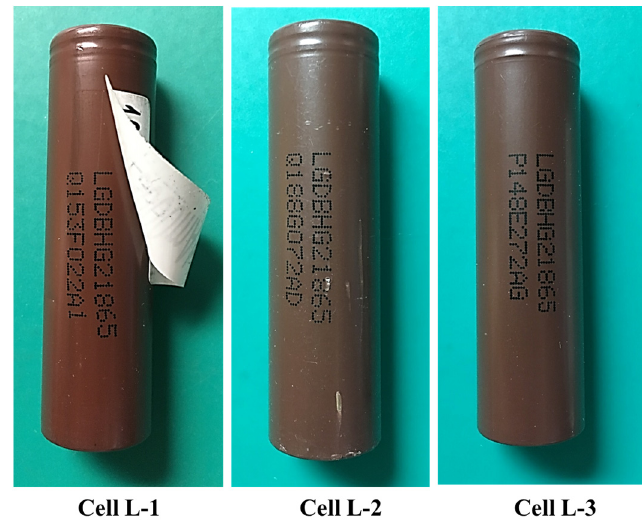
Figure 5. Serial numbers printed on the outer casing.